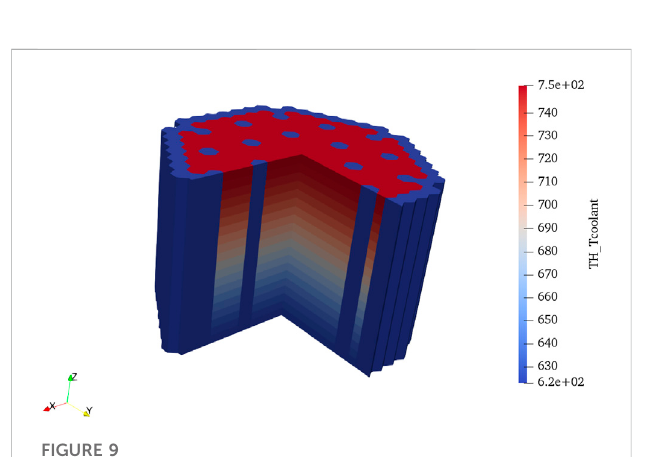
FIGURE 9 Temperature distribution of the